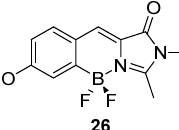
Figure 25. GFPc analogue with the Z/E isomerization blocked by intramolecular interaction [41].